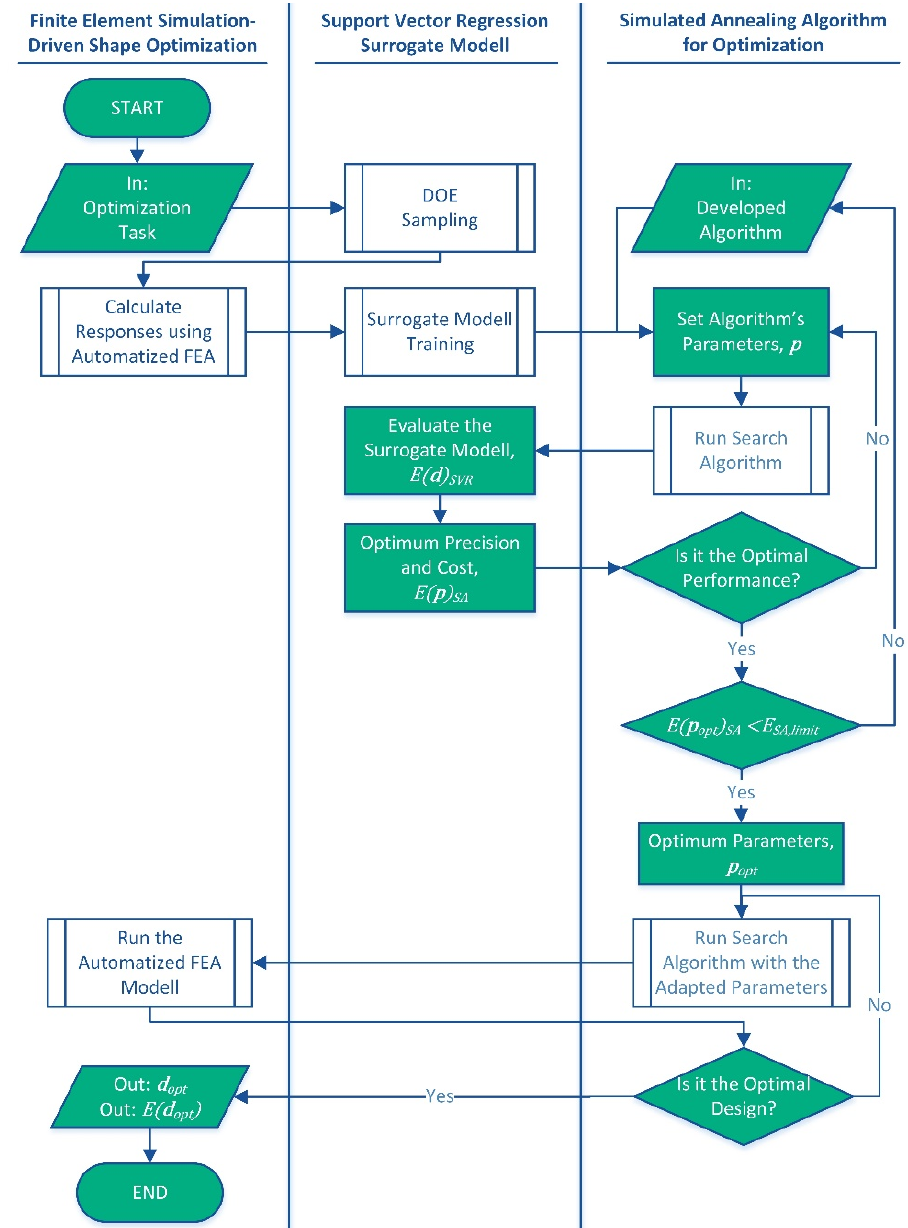
Figure 5. Flowchart of the developed surrogate model-based parameter tuning of optimization